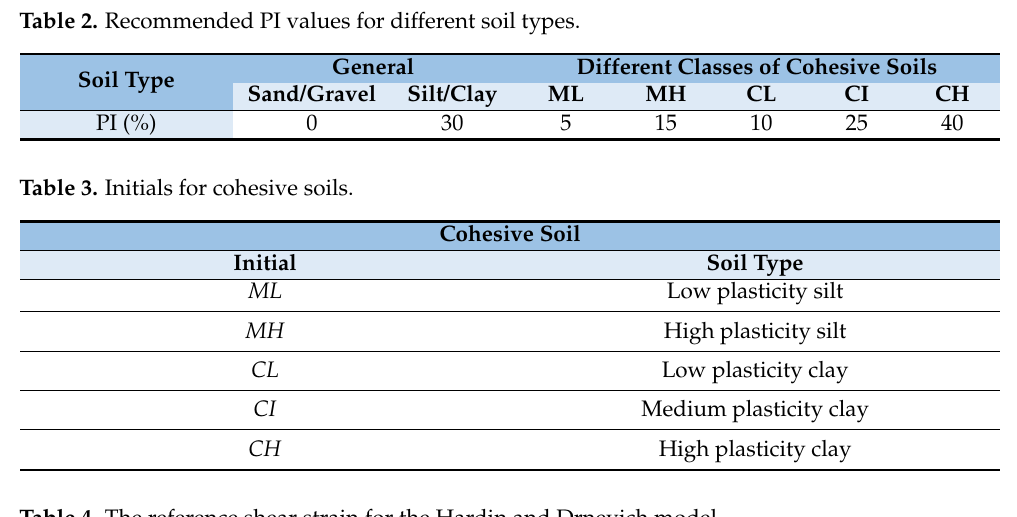
Table 4. The reference shear strain for the Hardin and Drnevich